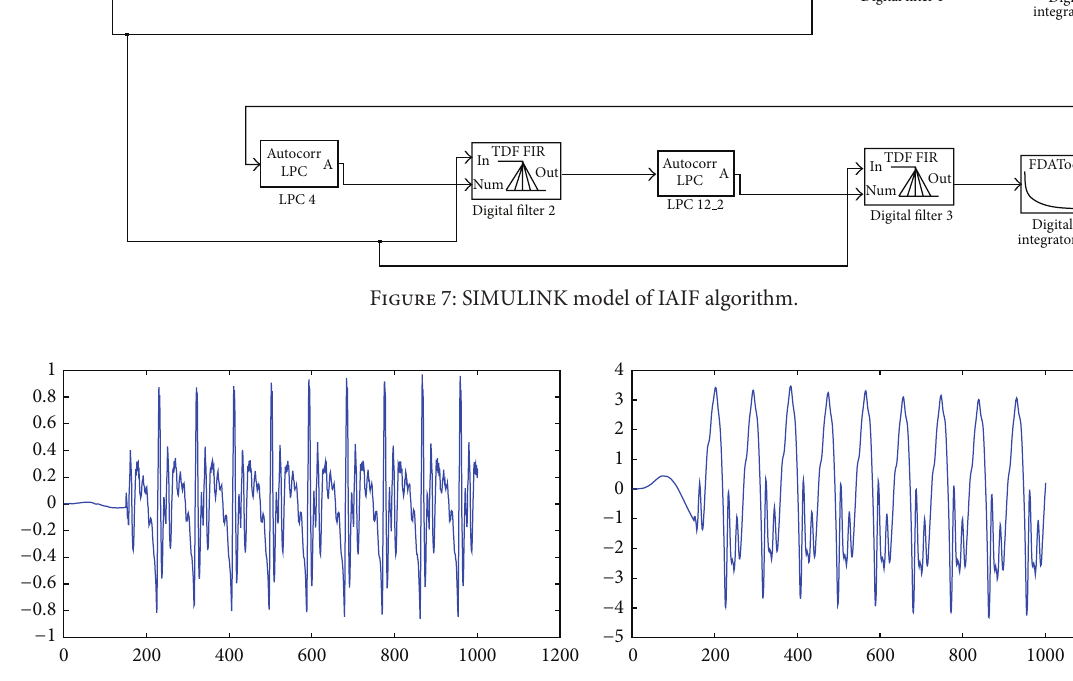
Figure 8: Input speech waveform and Output glottal waveform of IAIF algorithm for vowel /a/.